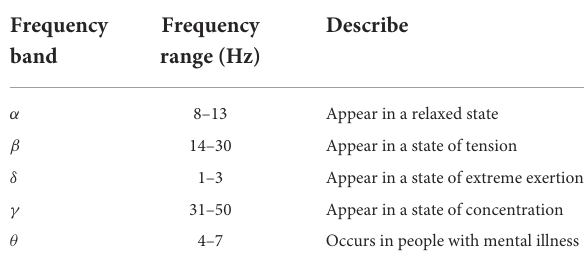
TABLE 2 A summary of EEG